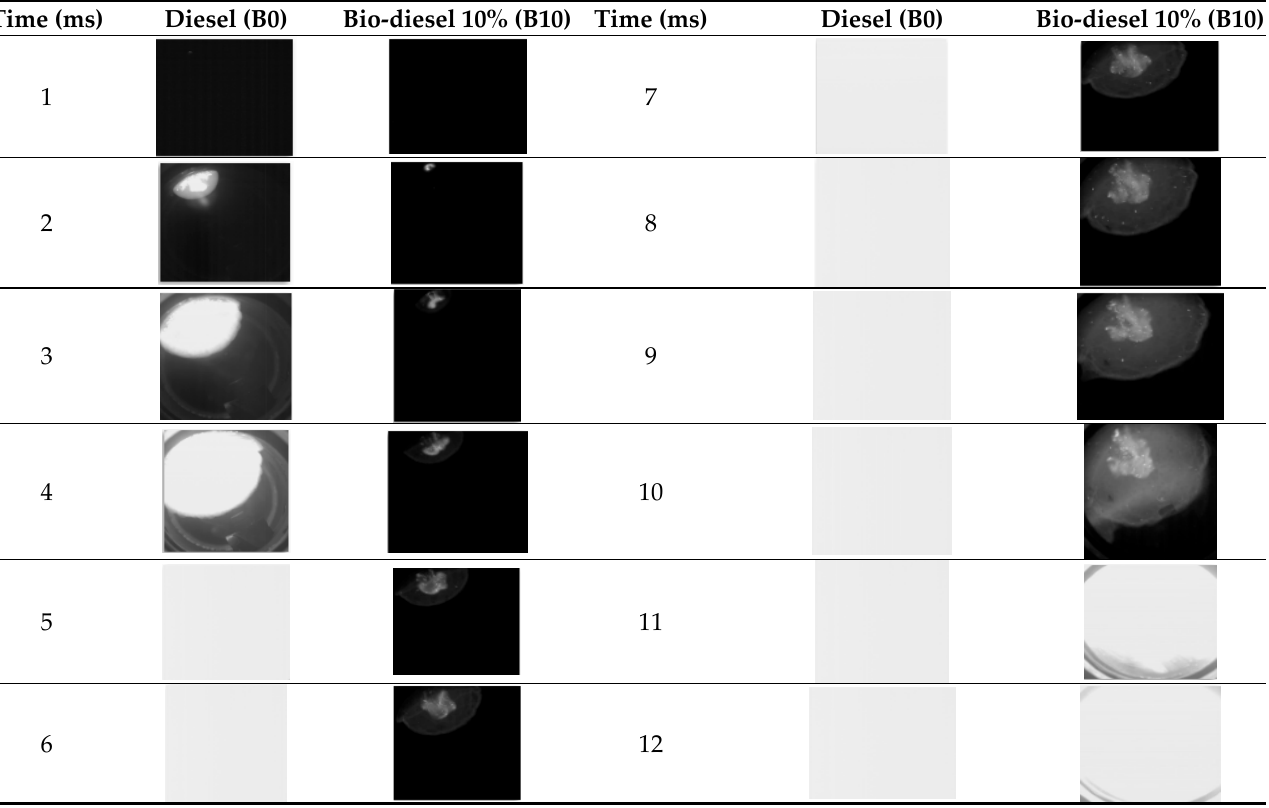
Figure 4. Image of pilot combustion spreading the flame film of the fuel in a constant volume combustion chamber (diesel (B0), 10% bio-diesel (B10)). Specifically, diesel and bio-diesel fuel have flame membrane lengths of 44 (mm) and 17 (mm), respectively. Figures 5 and 6 show that the flame spread rate of diesel fuel is about two times higher than that of bio-diesel fuel, which is 10%. The reason is that diesel fuel has a higher low calorific value, a lower flash point, lower viscosity, and better air-conditioning quality, resulting in faster flame film propagation.